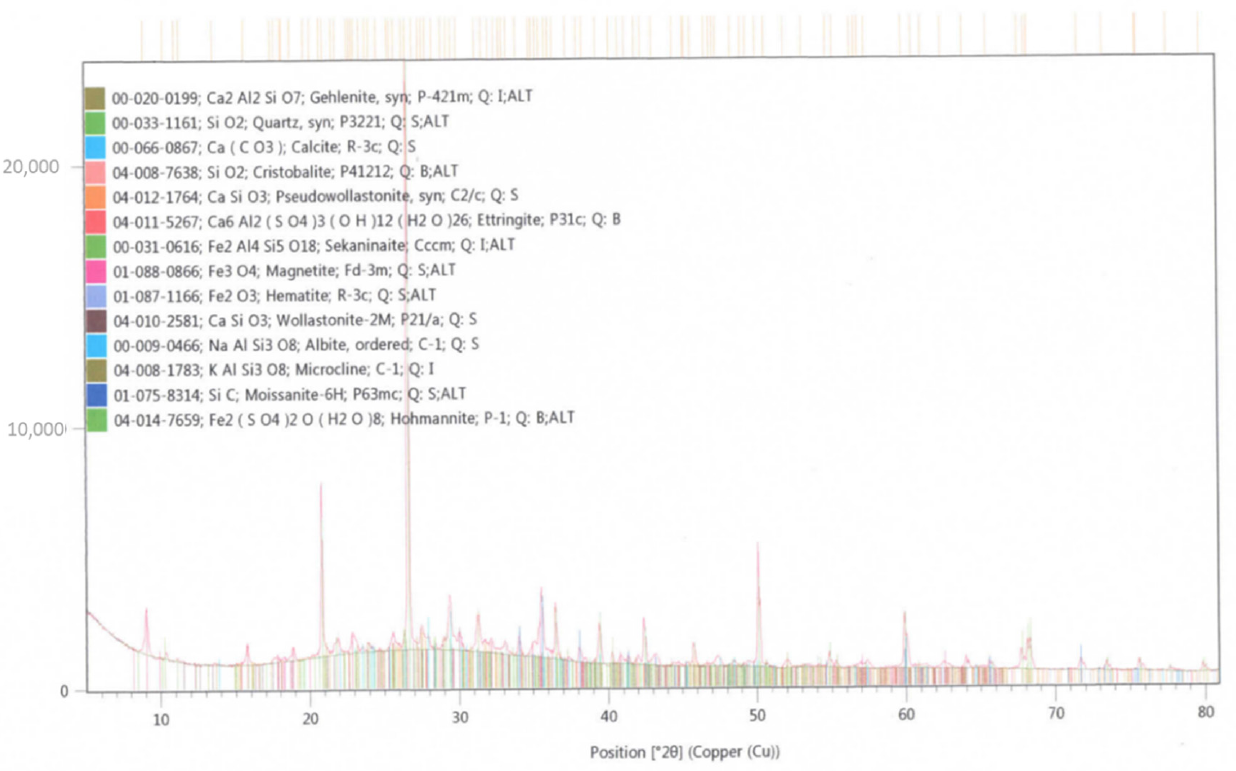
Figure 9. MSWIBA glassy phase.